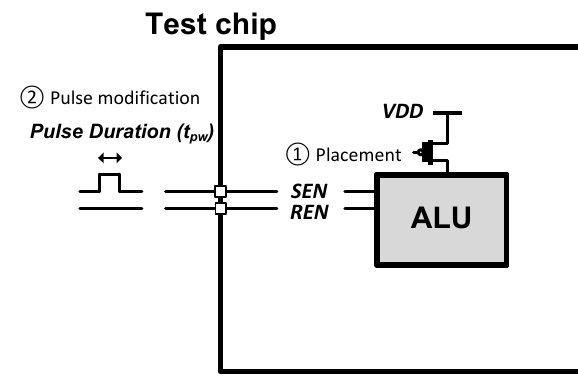
Figure 4. Overview of the proposed two-phase optimization